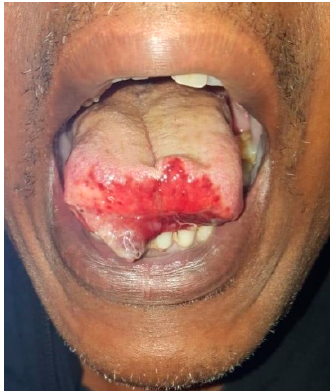
Figure 1. The amputated anterior third of tongue was brought to the emergency department (ED) in a plastic box containing tap water.